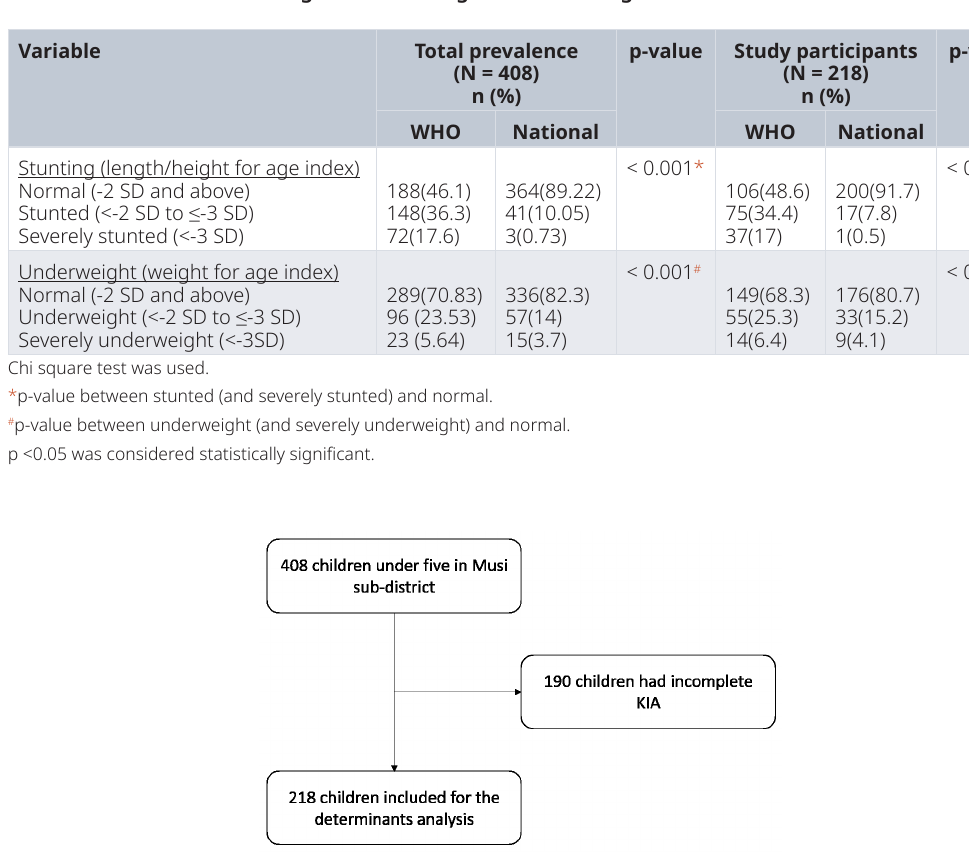
Figure 1. Flow chart of the study population selection for determinants